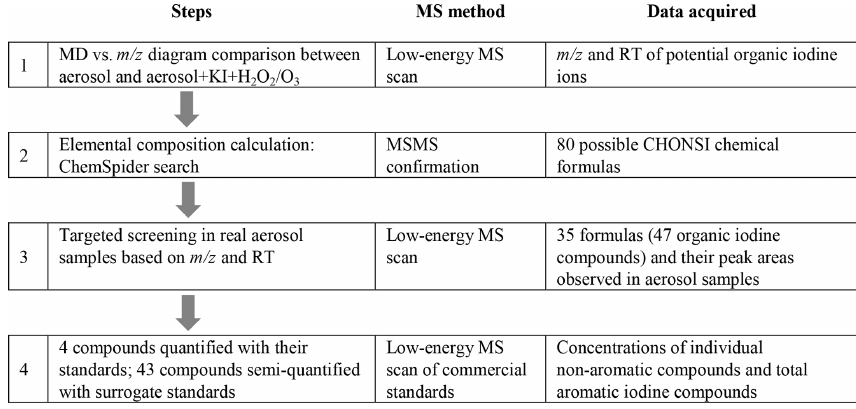
Figure 4. Identification and semi-quantification steps of unknown organic iodine compounds in ambient aerosols.